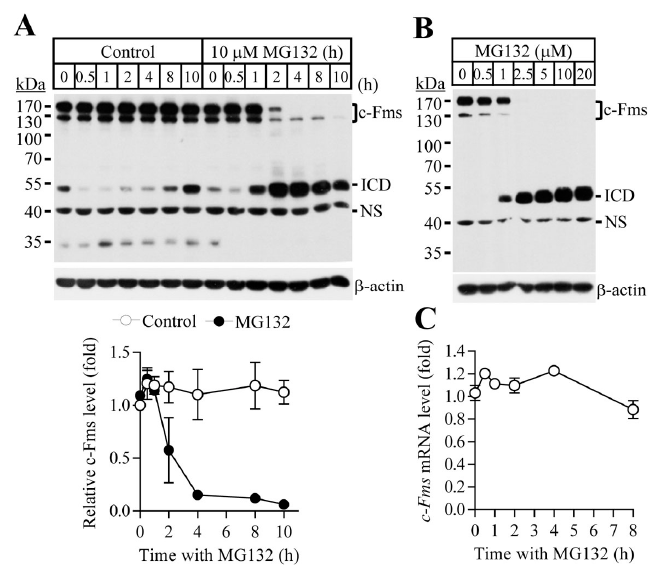
Figure 2. MG132 downregulates the levels of c-Fms protein, but not c-Fms mRNA. Osteoclast progenitors were treated with MG132 (10 µ M) for the indicated times ( A ) or with various concentrations of MG132 for 4 h ( B ). ICD, intracellular domain of c-Fms; NS, nonspecific bands; ( C ) cells were treated with MG132 (10 µ M) for the indicated times, and relative mRNA levels of c-Fms were analysed by quantitative real-time PCR using GAPDH mRNA as a control.